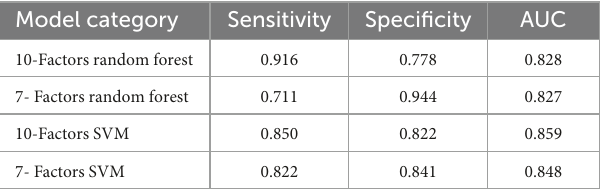
TABLE 3 Comparison of invalidation result of prediction